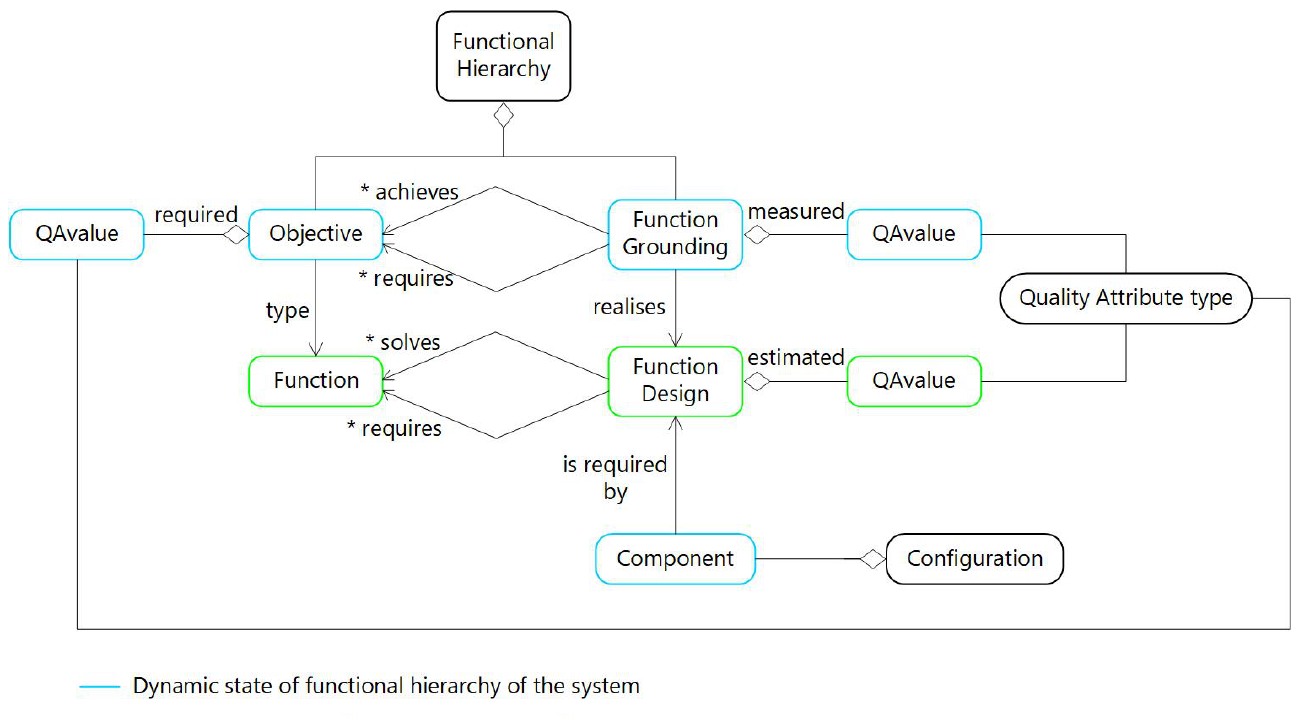
Figure 6. Main elements of Teleological and Ontological Model of an Autonomous System (TOMASys) metamodel, the * symbol represents the possible multiplicity in the destination